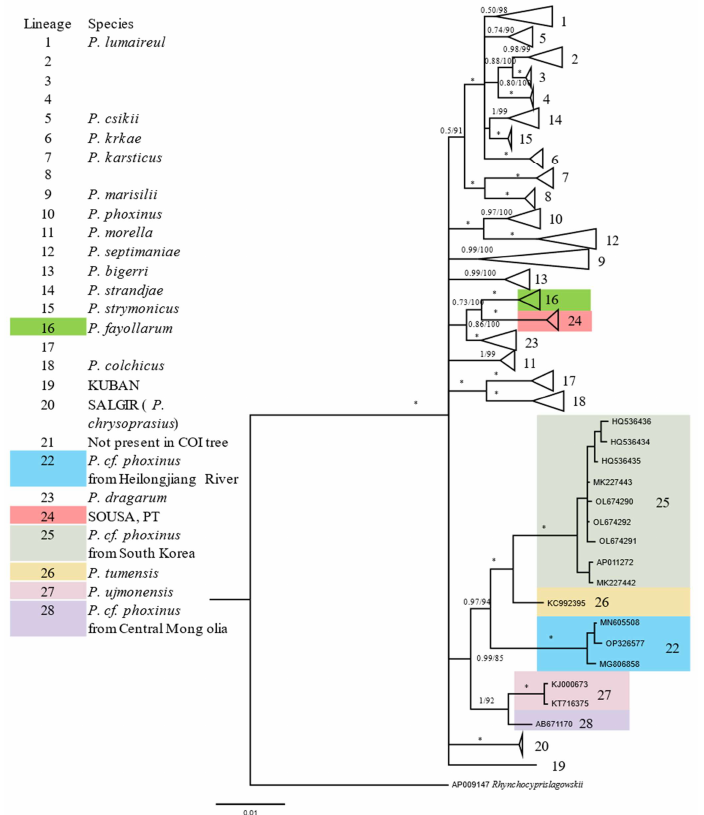
Figure 4. A Bayesian inference (BI) tree of Eurasian Phoxinus based on cytochrome oxidase I (COI) data. Posterior probability values for BI (BPP) and bootstrap values for maximum-likelihood (ML) are shown on branches. The sign ‘’*‘’ indicated BPP of 1 and Bootstrap values of 100. Genetic lineages are presented in the upper left corner. The genetic lineages that are valid species are written on the right. Only newly added or modified lineages are marked in color. Asian clades were expanded to show the sequence contained in each lineage more clearly. Rhynchocypris lagowskii (AP009147) was used as the outgroup.